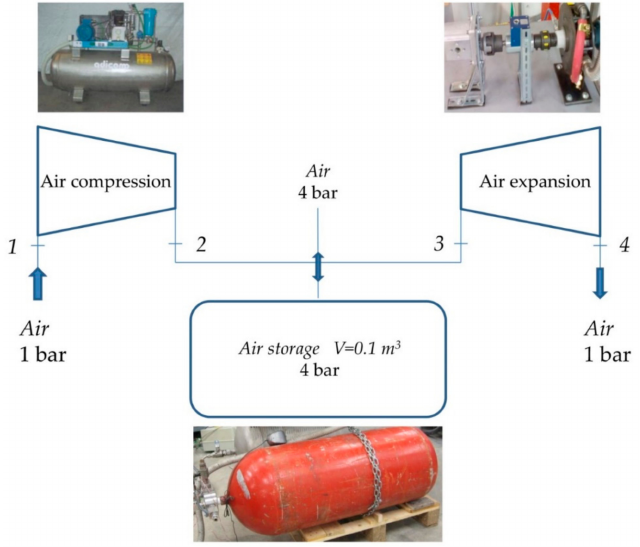
Figure 2. Experimental